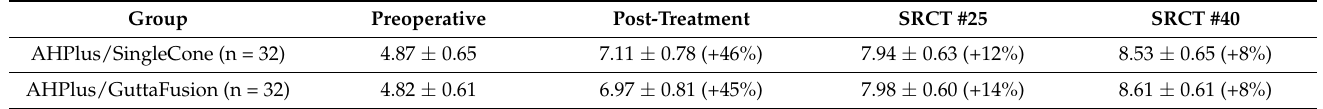
Table 2. Root canal Area (mm 2 ) calculated on radiography: preoperative, post-treatment, after secondary treatments with RB #25 and with RB #40. Percentage of increase after each treatment is reported. Mean ± Standard